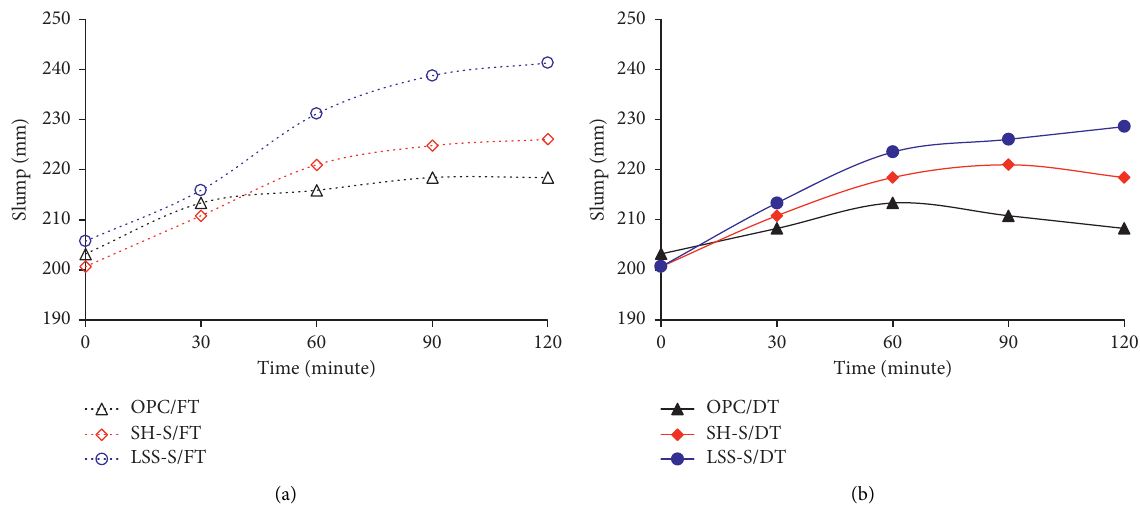
Figure 4: Workability characteristics of CPB mixtures for FT and DT.